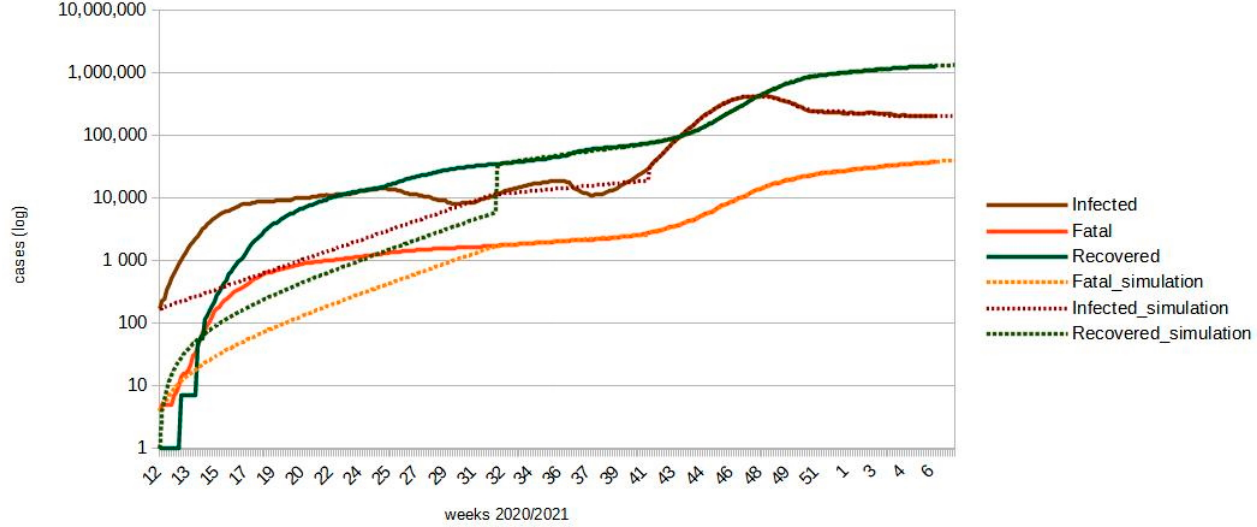
Figure 5. Poland, COVID-19: Simulation of cases over time (as of 13 February 2021; results: CovsirPhy Python Application).